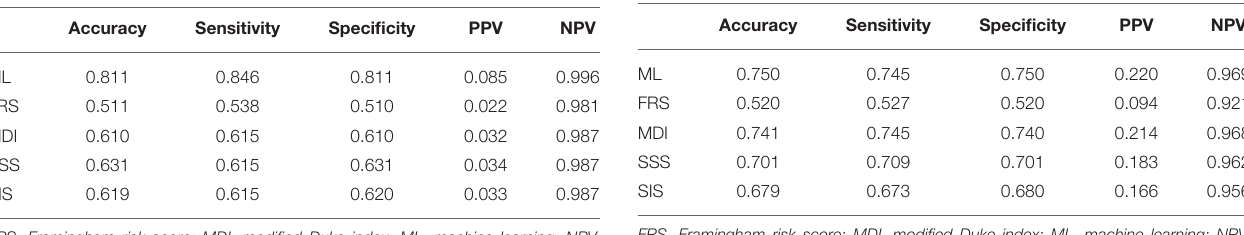
TABLE 3 | Accuracy, Sensitivity, specificity, positive predictive value, and negative predictive value of our ML method and existing methods for prediction of major adverse cardiac